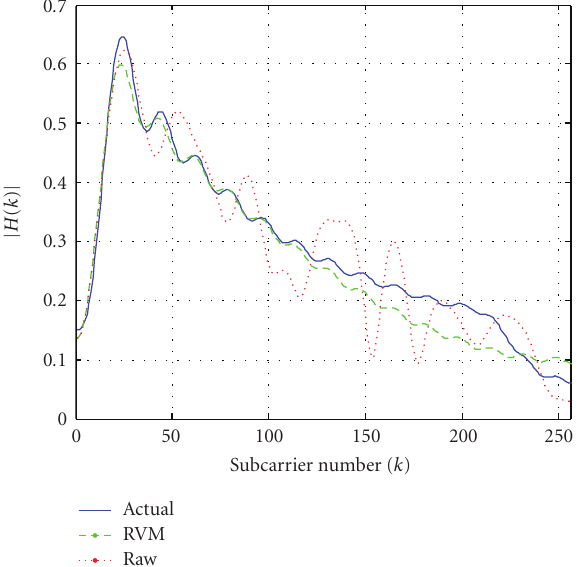
Figure 5: Frequency response of actual and estimated channel.